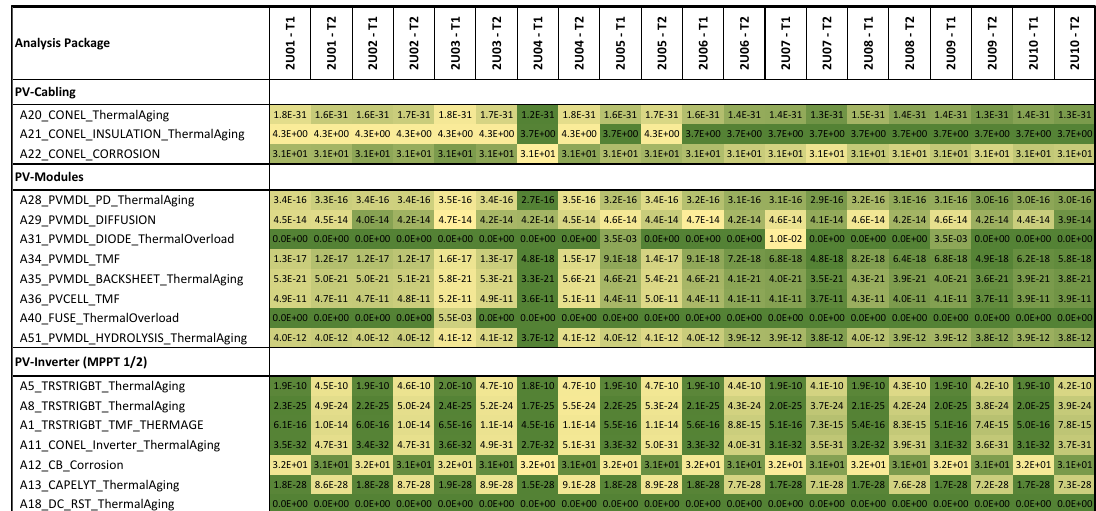
Figure A1. Damage calculation results for MPPTs “1U01 - T1”–“ 1U09- T2” .